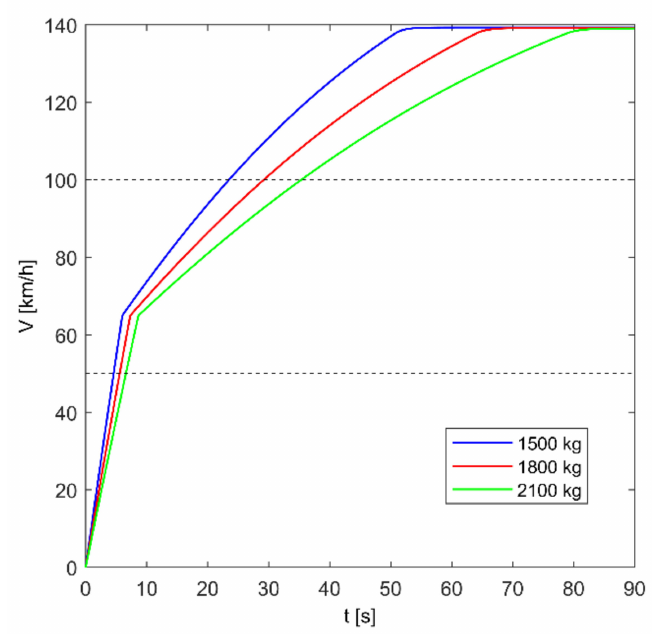
Figure 8. Acceleration plots of simulated